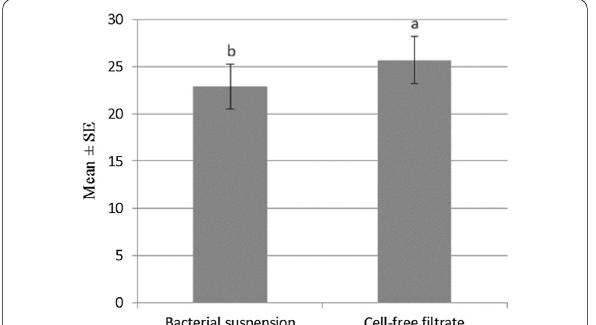
Fig. 1 Mortality of Locusta migratoria migratorioides after treatment with bacterial suspension of P. luminescens (EGAP3) and its cell-free filtrate. Bars (mean SE in the same and between time intervals with ± the same letter(s) are not significantly different ( P < 0.005)